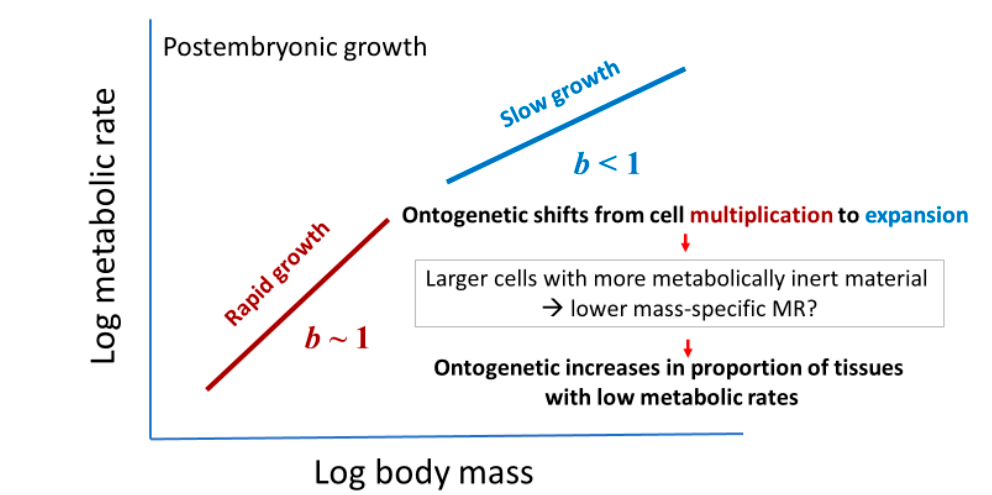
Figure 4. Ontogenetic shifts in metabolic scaling tend to be associated with rapid growth in early postembryonic development and slower growth in later development [9,14]. Additional possible processes involved in these ontogenetic shifts are changes from mainly cell multiplication to cell expansion and increases in proportions of tissues with relatively low metabolic rates [9,14]. These two processes may be linked, at least in part, by the ontogenetic development of larger cells with more metabolically inert materials, as in animal adipose tissues and structural tissues in vascular plants (see also Figure 6).